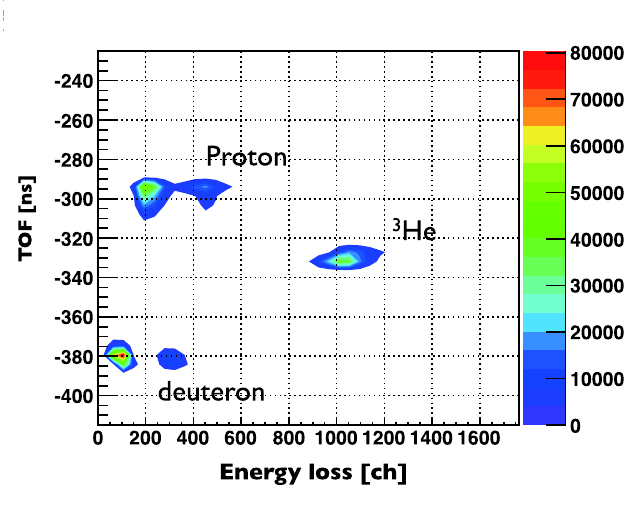
Fig. 2. Particle identification capability of the detector system by measuring the TOF between F5 and F7 and the energy loss in the F5 scintillator. 3 He particles are identified with perfect background